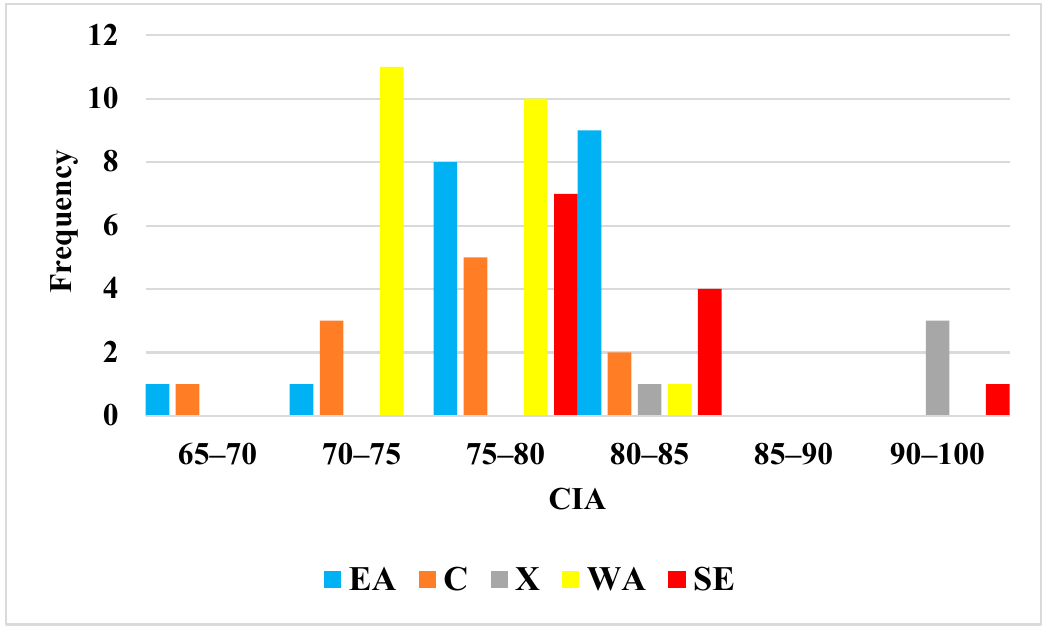
Figure 9. Chemical index of alteration (CIA) for the studied samples from western Achaea (WA) and south Epirus (SE) in comparison with the CIA of the samples from the northeastern Peloponnese (EA: eastern Achaea, C: Corinth, and X: Xylokastro). Table 4. Elemental concentrations (wt.%, water-free basis) obtained through X-ray fluorescence for the clay-rich samples .